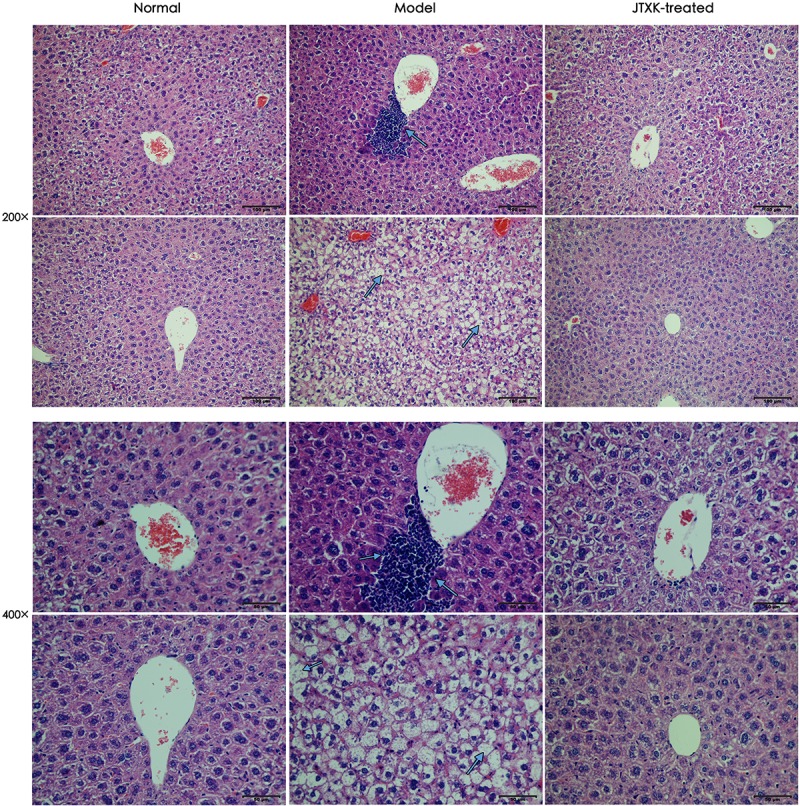
H&E Staining of hepatic tissue. Representative histology images in each group were exhibited (200, 400×). Normal: normal group, mice were fed with standard diet; Model: M group, mice were fed with 45% HFD; JTXK-treated: J group, mice were fed with 45%HFD and administrated with JTXK granule.